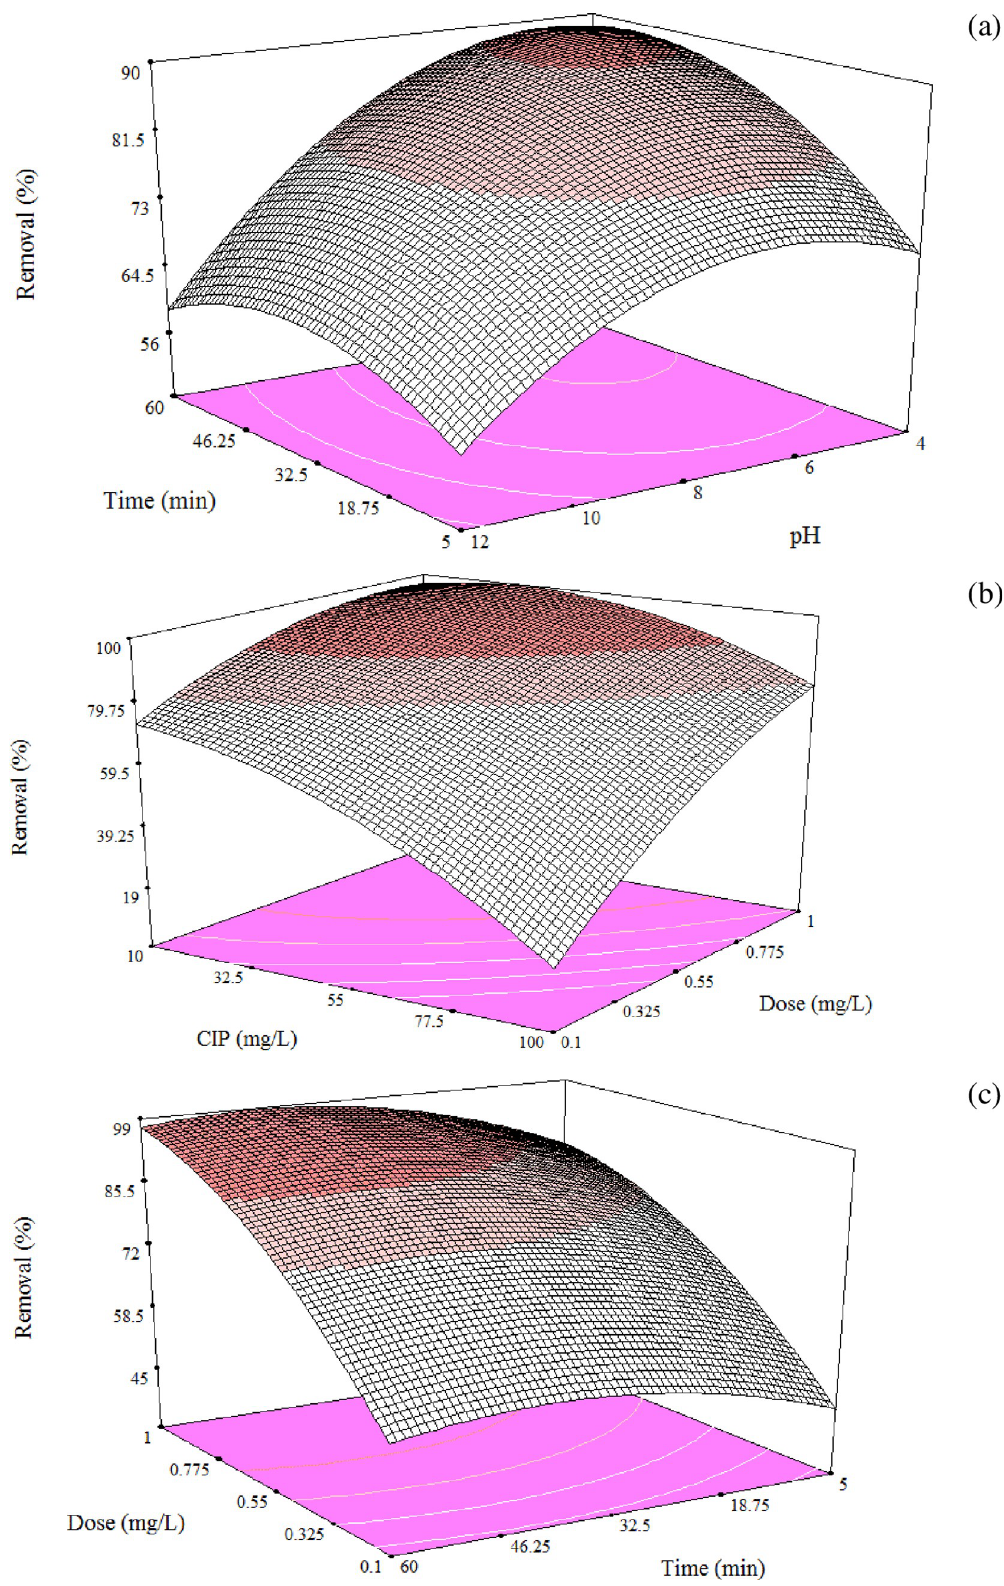
Fig 6. CIP removal as a function of operating variables, (a) the effect of pH and time (b) CIP concentration and adsorbent dose, and (c) adsorbent dose and agitation time.